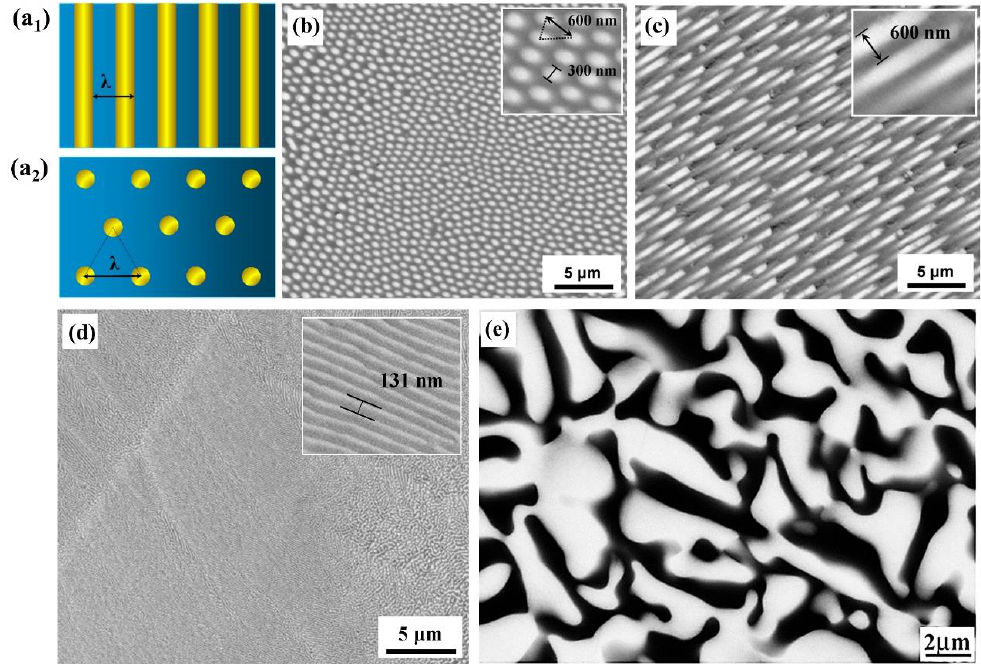
Figure 6. Schematic geometries of ideal cross-sections and eutectic spacing of the ( a 1 ) lamellar and ( a 2 ) fibrous eutectic structures; back-scattering electron images showing the microstructure of the Al 2 O 3 -ZrO 2 nanoeutectic of ( b ) the regular fibrous eutectic structure, ( c ) the longitudinal section of ( b ) and ( d ) the regular lamellar eutectic structure; and ( e ) the back-scattering electron image showing the microstructure of the Al 2 O 3 -GdAlO 3 irregular eutectic. Reproduced with permission from Reference [100], Copyright © 2018 Elsevier Ltd., Reference [33], Copyright © 2018 Elsevier Ltd. and Reference [46], Copyright © 2018 Elsevier Ltd. and Techna Group S.r.l.